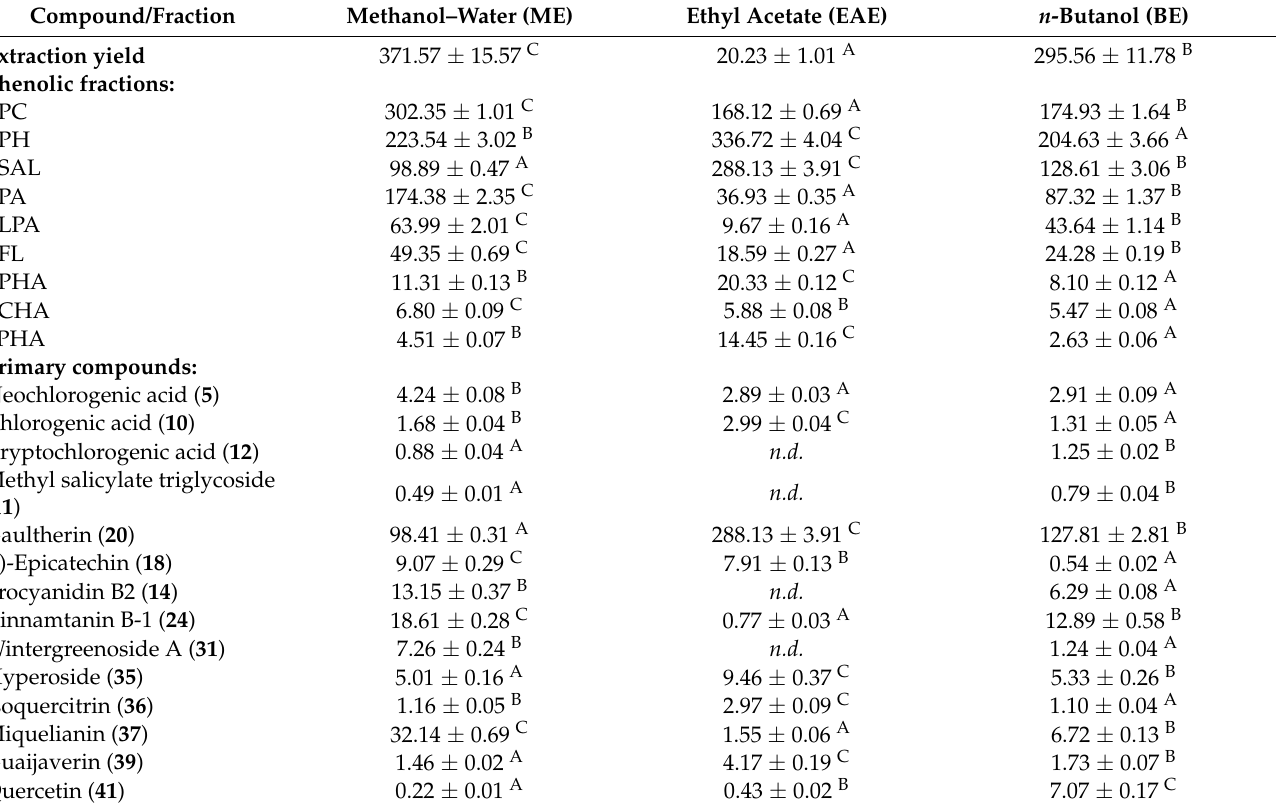
Table 1. Extraction yield and phenolic profile of G. procumbens leaf dry extracts (mg/g dw). Compound/Fraction